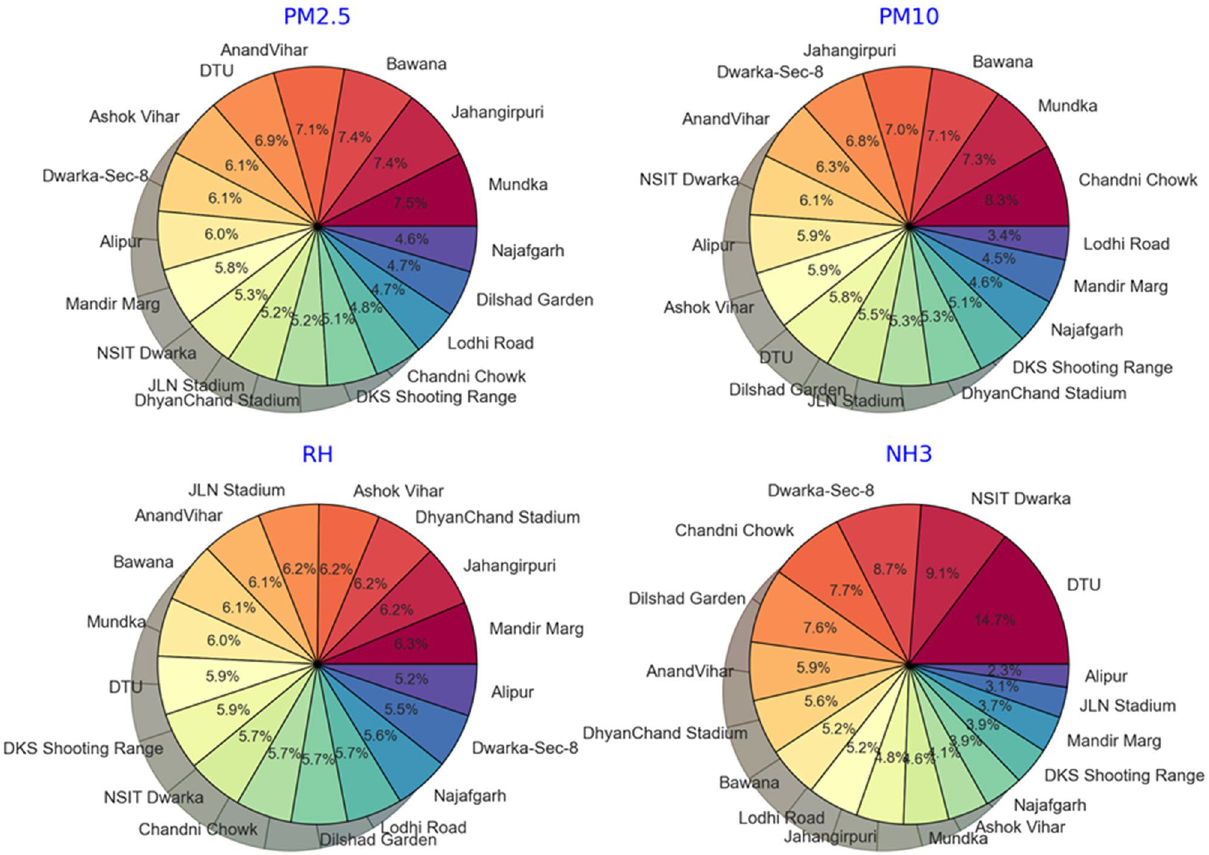
Figure 1. Pie chart showing the regional distribution of percentage contribution of variables observed from all sub-station locations to the overall AQI of Delhi to locate particular